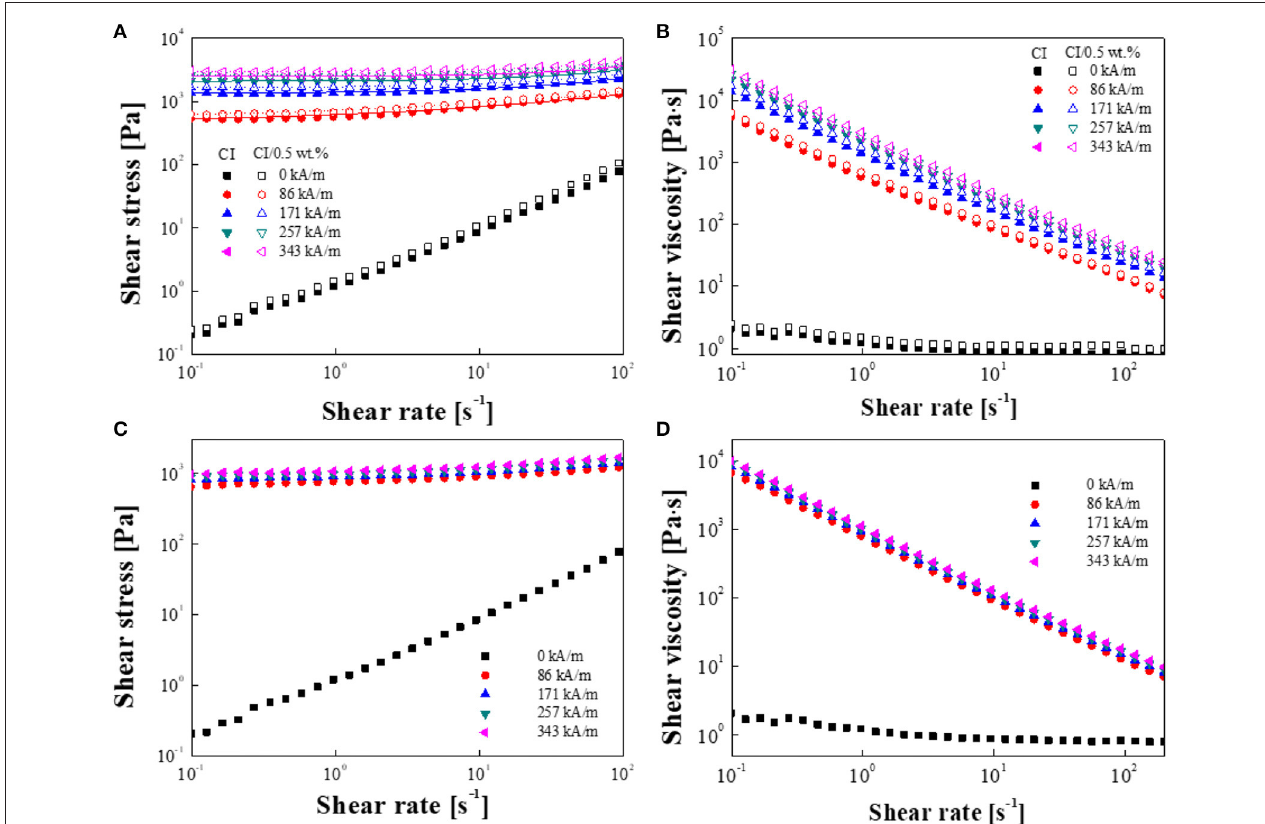
FIGURE 3 | (A) Shear stress and (B) shear viscosity of CI/ BaFe12O19 mixture-based MR fluid (open symbol) and pure carbonyl iron (CI)-based magnetorheological (MR) fluid (closed symbol), shear stress (C) , and shear viscosity (D) of pure barium ferrite (BF)-based MR fluid as a function of shear rate under various magnetic field